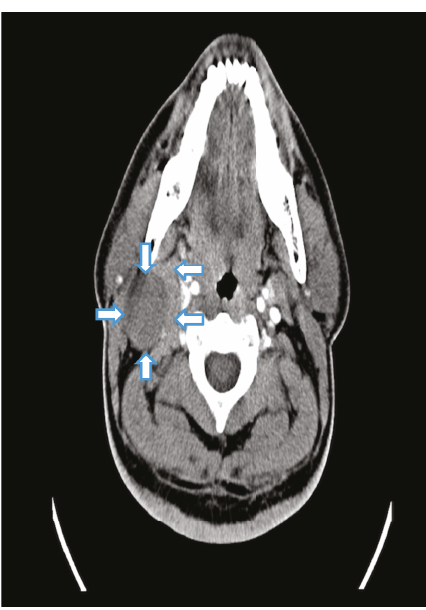
Figure 1: Swelling on the right side of the neck below the angle of mandible.